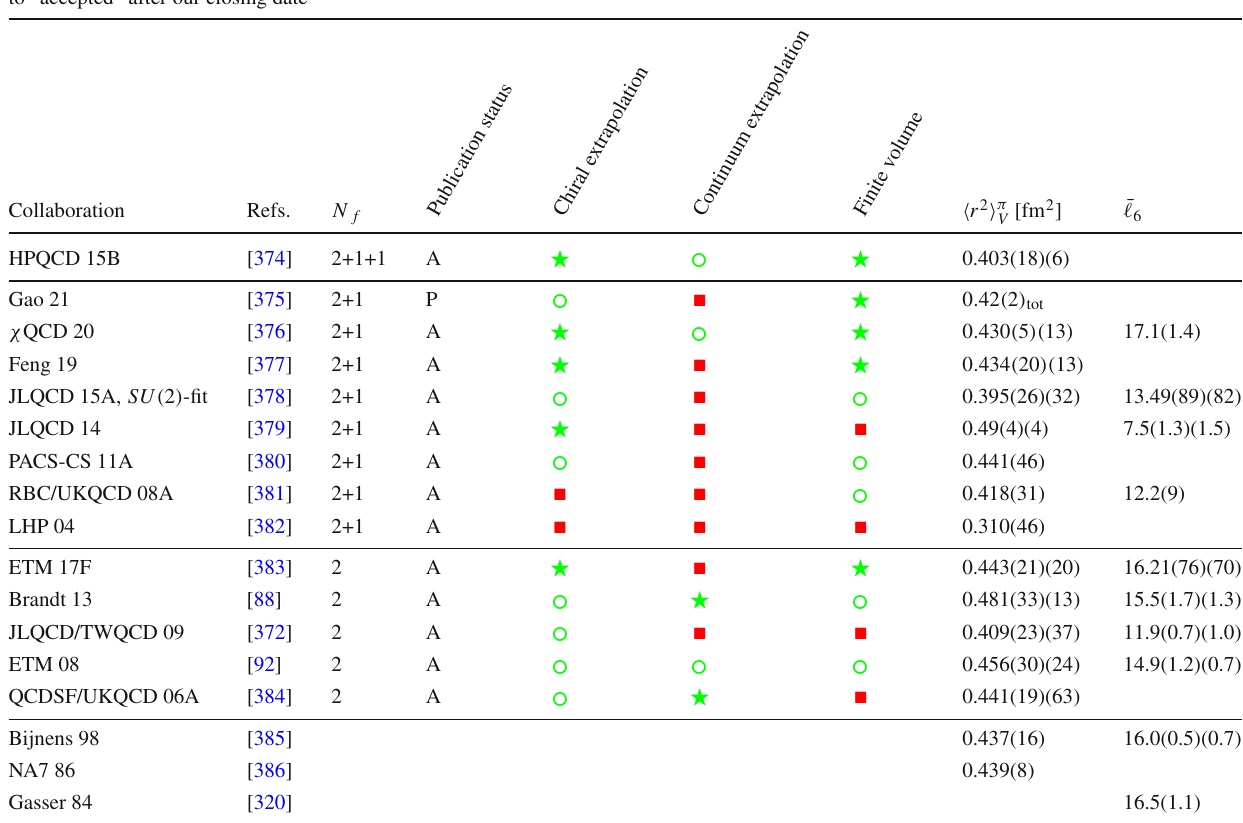
and the chiral coupling constant ¯ (cid:6) 6 are compared with the V